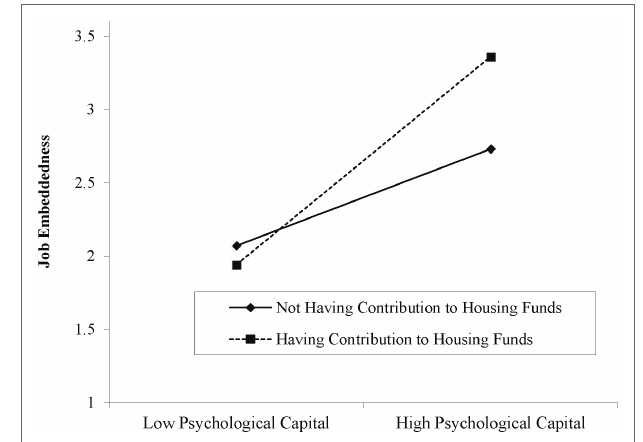
FIGURE 2 | Moderation role of satisfaction toward house price between psychological capital and job embeddedness.